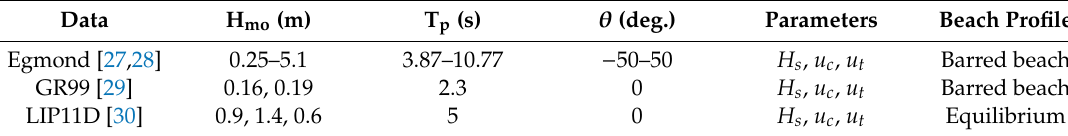
Table 2. O ff shore wave conditions and measured data for model